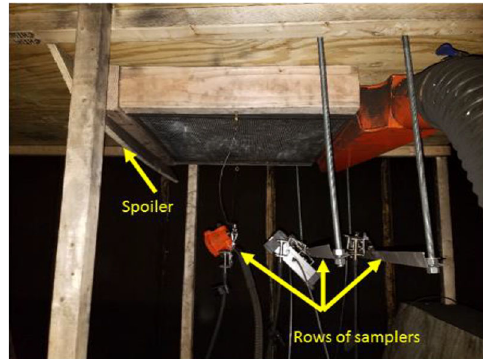
Fig. 10 Photo showing additional sampling row added to provide full sampling coverage underneath the CAC. Spoiler is shown on the front of the CAC